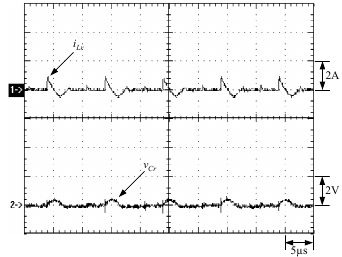
Figure 16. Waveforms pertaining to L r and C r at the minimum load: (1) i Lr ; and (2) v Cr .